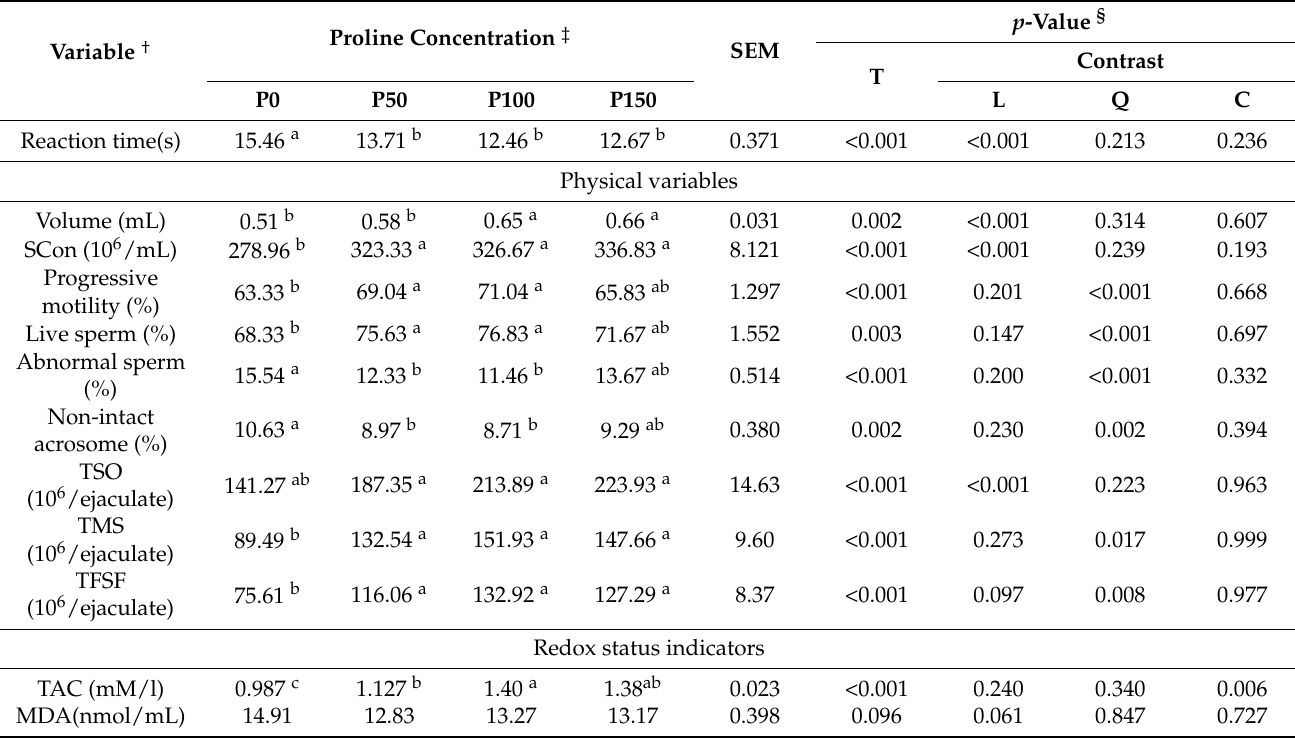
Table 5. Concentration-dependent effects of proline supplements on reaction times (libido), semen physical variables, and seminal plasma redox status indicators in rabbit bucks; data are expressed as least square means ± standard errors of the mean